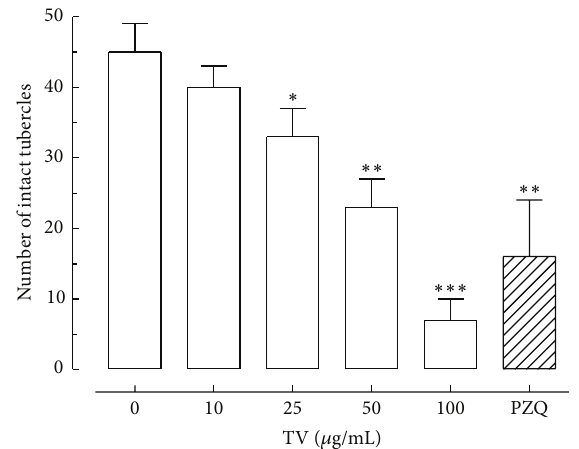
Figure 5: Quantitative analysis of morphological alterations on the tegument of S. mansoni after exposure to different concentra- tions of the crude hydroalcoholic extract of T. vulgare (TV). The quantification of the number of tubercles was performed using three-dimensional images obtained from laser scanning confocal microscopy. Indicated are numbers of intact tubercles, and these numbers were measured in a 20 000 𝜇 m 2 area in a dorsal region of Schistosoma mansoni adult male worm (see Figure 4(a)) and calculated with the Zeiss LSM Image Browser software. Praziquantel (PZQ, 10 𝜇 M) was used as a positive control. A minimum of three tegument areas of each parasite were assessed. Values are means ± SD (bars) of ten male adult worms. ∗ 𝑃 < 0.05 , ∗∗ 𝑃 < 0.01 , and ∗∗∗ 𝑃 < 0.001 compared with untreated